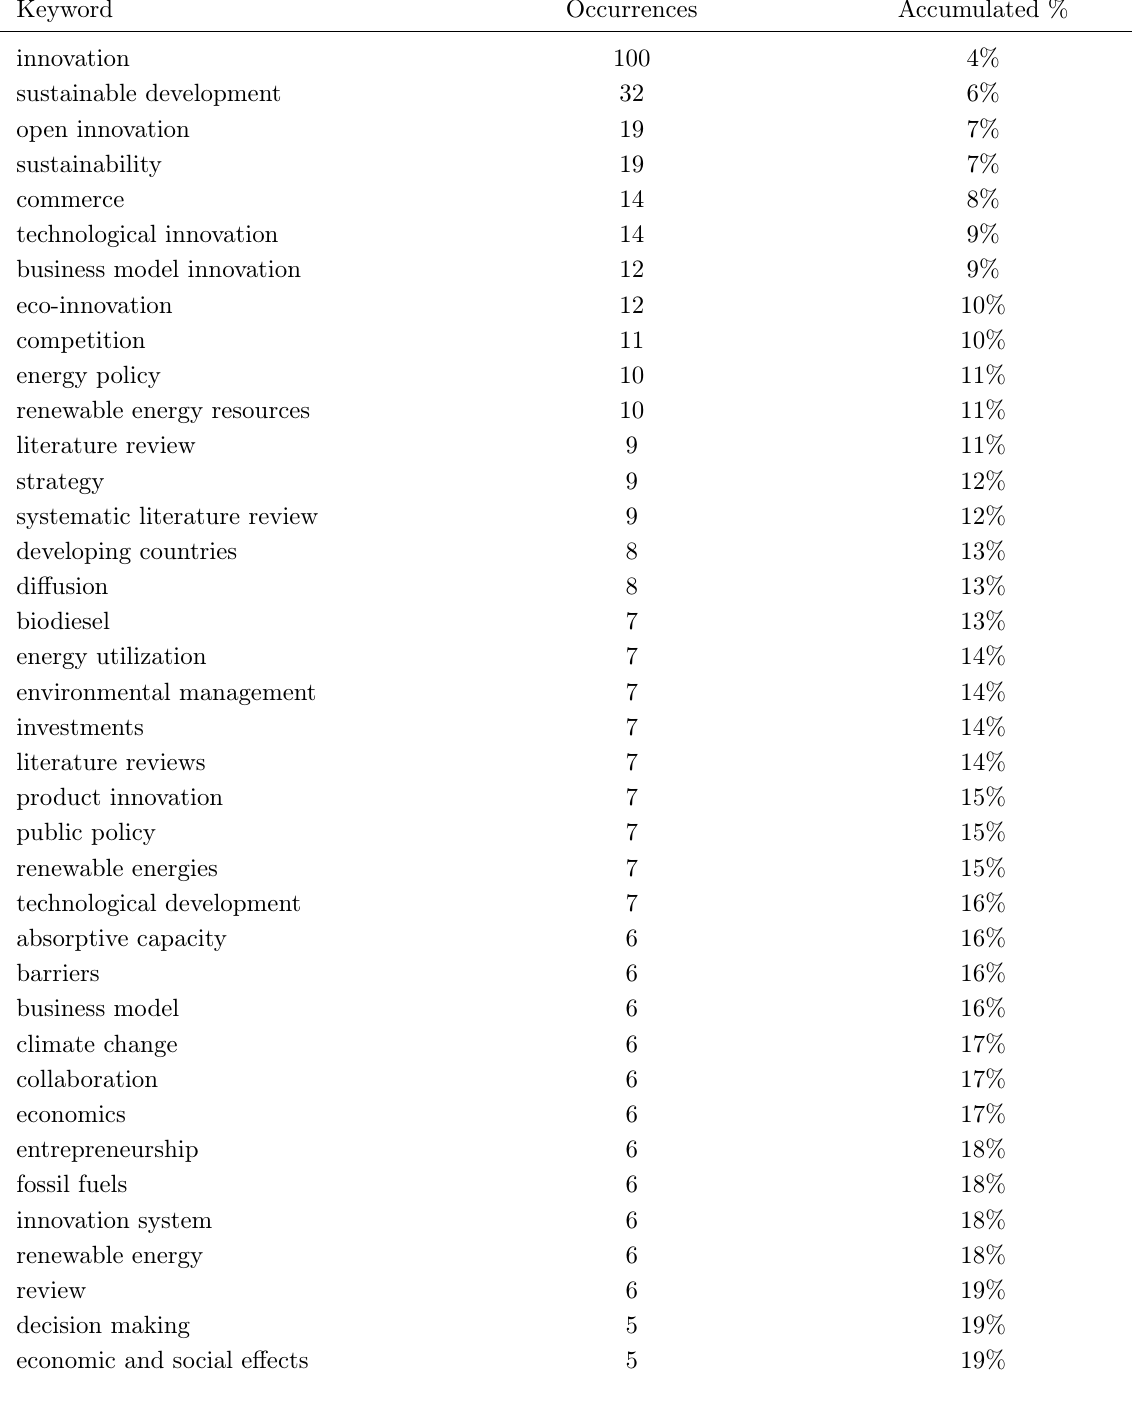
Table 4. Occurrences of 71 Keywords representing 25% of the total occurring in the 195 pa-